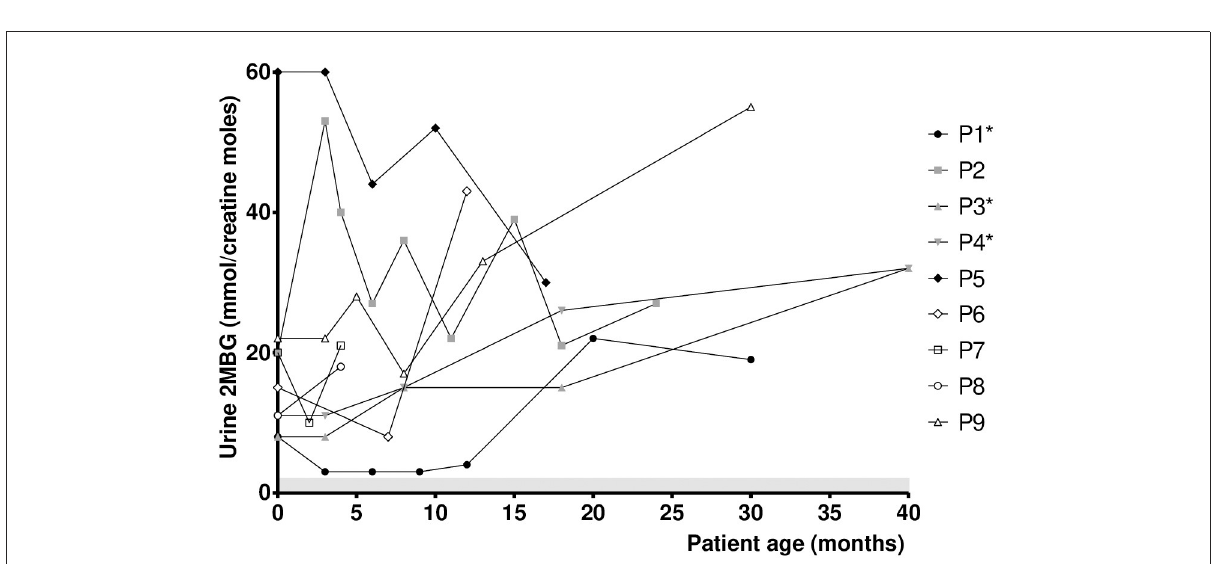
FIGURE2 Urine 2MBG values in SBCADD patients. For each subject the first time point shows the urine 2MBG value detected upon NBS recall before starting the L-carnitine treatment (100 mg/kg/day). Subsequent time points show urine 2MBG value after starting with L-carnitine treatment. 2MBG reference range is highlighted (shaded area). *Data for P1 at 24 months, P3 and P4 at 12 and 24 months were not collected due to COVID19